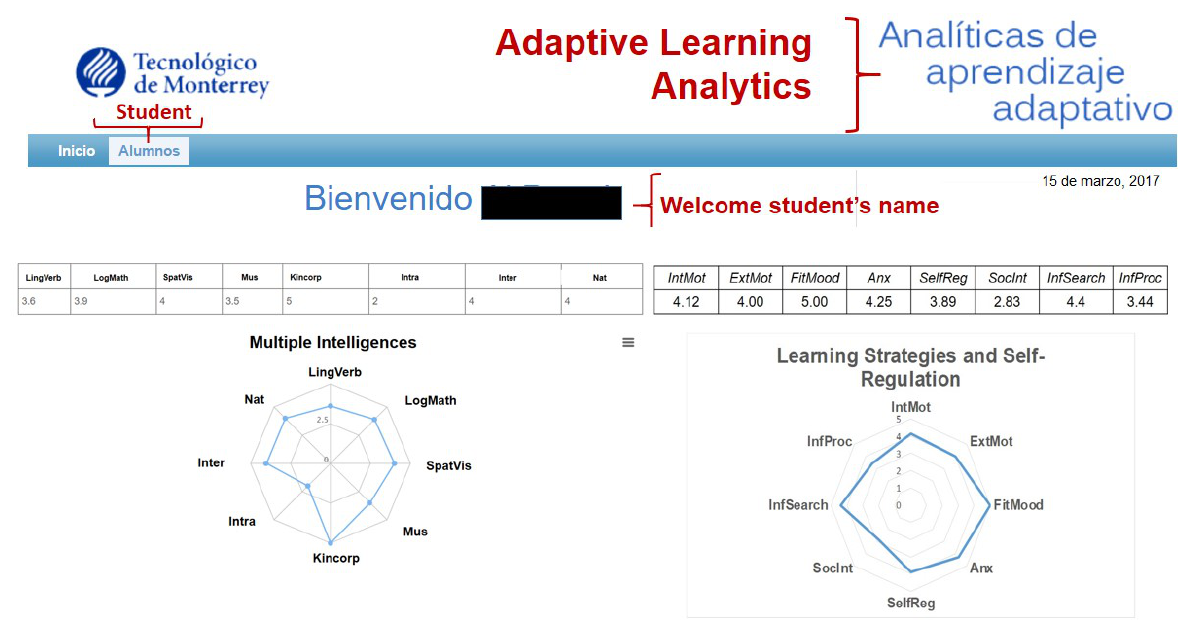
Figure 2. Example of Basic Student’s Dashboard of the results of the application of the questionnaires of MI ( left ) and SRLAS ( right ) for a